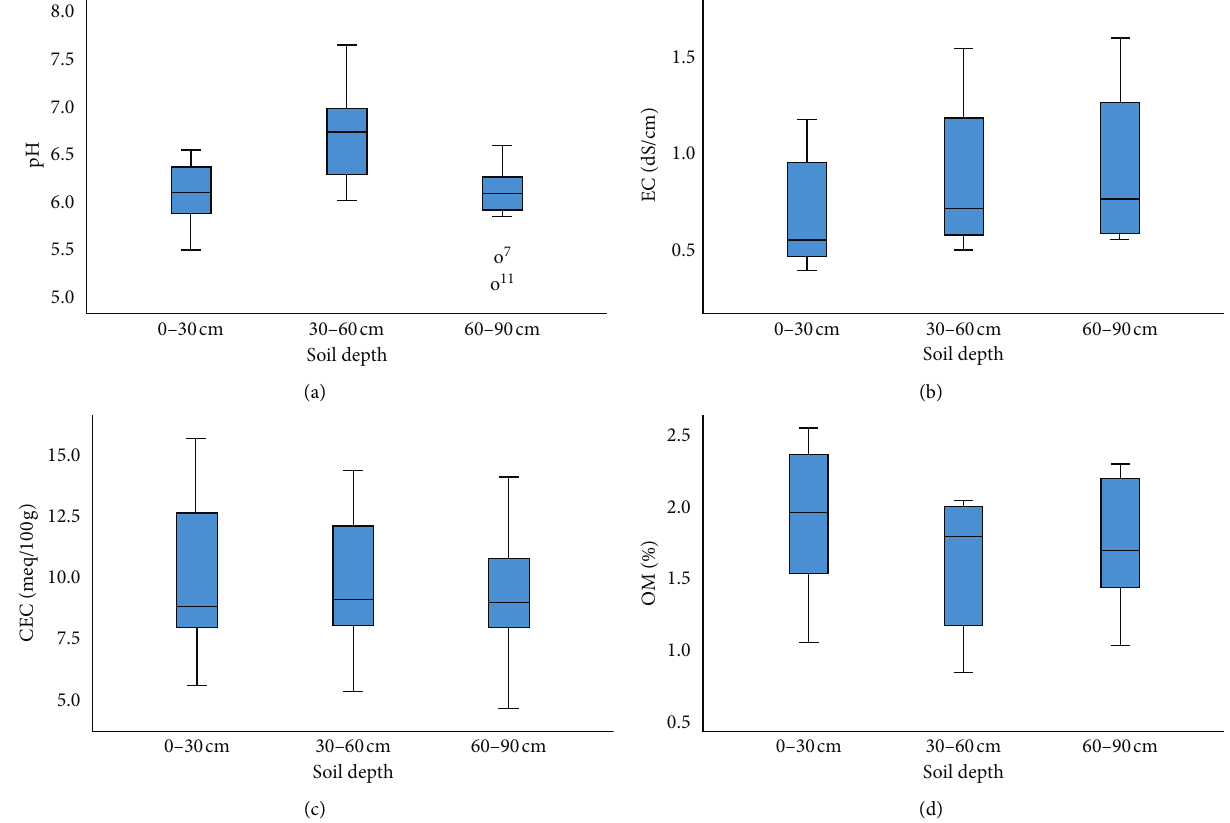
Figure 3: Physicochemical properties of soils around the